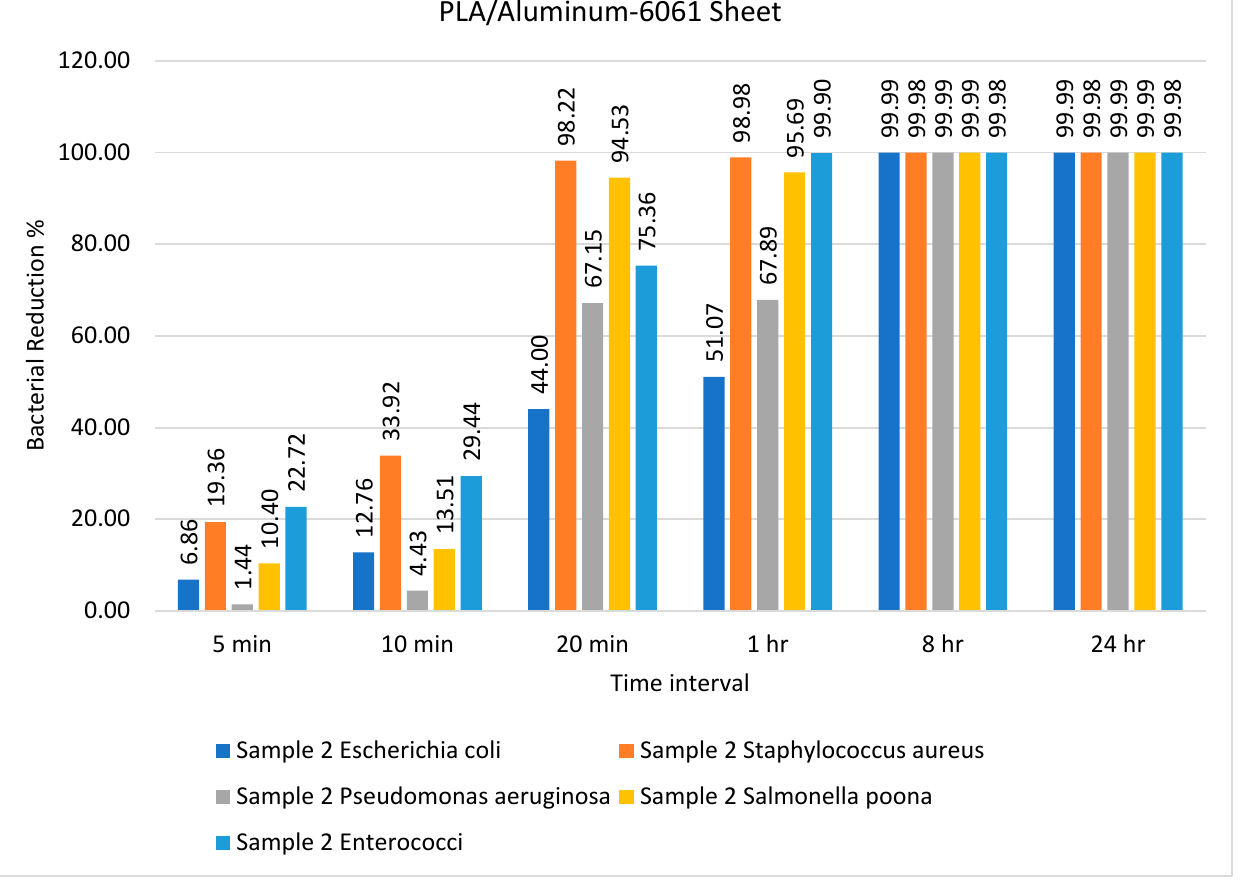
Figure 7. Percentage bacterial reduction for PLA/aluminum-6061 sheet over different time intervals.